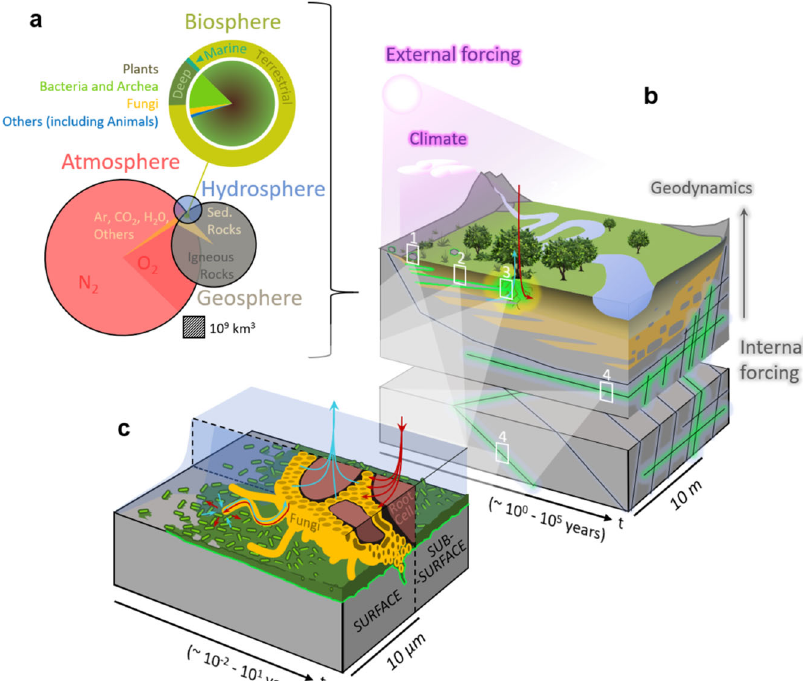
Fig. 1 Fluid – mineral – (micro)organism interactions across scales. a Earth system science representation of the biosphere at the intersection of the different components of the Earth system scaled to their respective volumes, providing an approximate global composition (in vol. %) of the compartments interacting at the surface of the Earth as well as the color code used in this review. b Co-evolution of a rock substratum and above-ground landscape driven by “ external forcing ” (i.e., solar radiation driving climate and photosynthesis) and “ internal forcing ” (mostly mantle processes resulting in geodynamics including uplift, volcanism, etc.). The (bio)chemical weathering of rocks is an important consequence of these forcings, along with other processes such as erosion. Regolith develops from the bedrock — with the formation of saprolite and soil horizons (pedogenesis) — as plants and microorganisms develop on mineral surfaces (ecosystem development). Rock substrates colonized by archaea and bacteria (green) as well as fungi (yellow), either on bare rocks (1), in the rhizosphere (2), in soil environment (3), or deeper in the subsurface (4), constitute potential bioweathering hotspots (see white boxes). c Similar representation at lower space and timescales for surface and subsurface environments, where mineral surfaces colonization by pioneering microorganisms is followed by bio fi lm development by bacteria, archaea, and fungi (green). Note, in both panels ( b ) and ( c ), the presence of microorganisms at the interface between mineral surfaces and their environment (either bulk fl uid or the rest of the ecosystem) where they can mediate fl uxes that are key to BW processes. These include water and inorganic nutrient transfer (blue arrows), as well as a reciprocal fl ux of carbon and nitrogen from the atmosphere (CO 2 , N 2 ) to the rhizosphere (organic molecules such as acids or carbohydrates — red) mostly mediated by plant photosynthesis and nitrogen fi